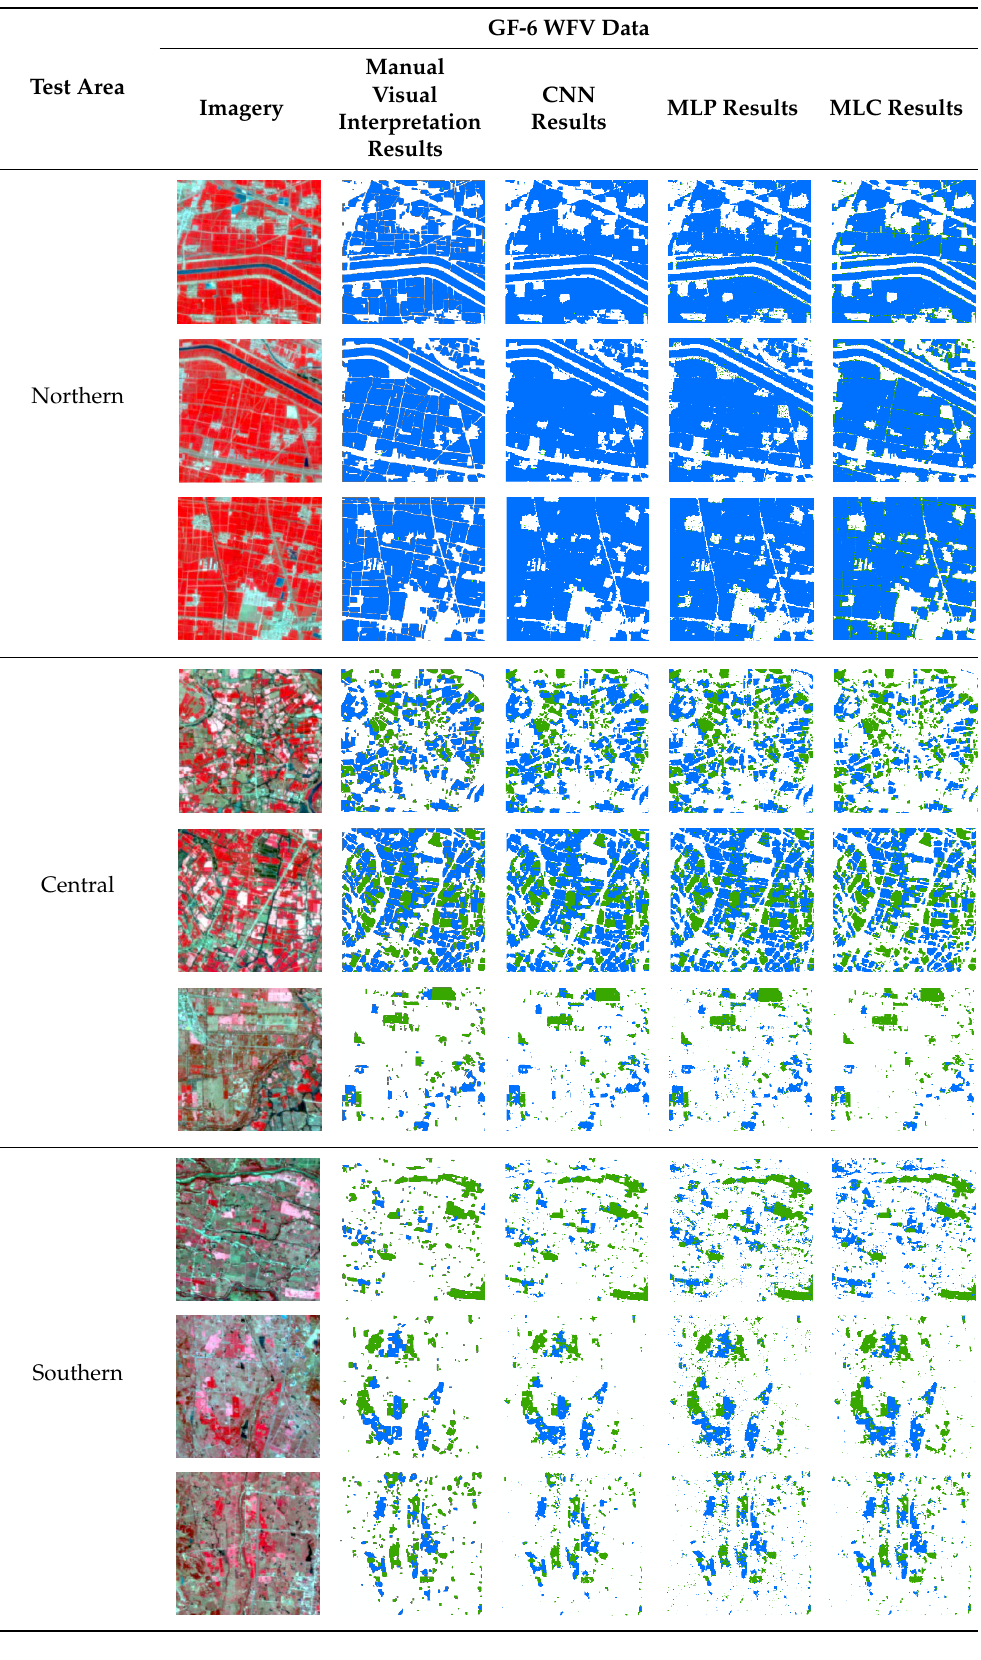
Table 12. Differences in the identification of winter wheat using different methods on GF-6 WFV.